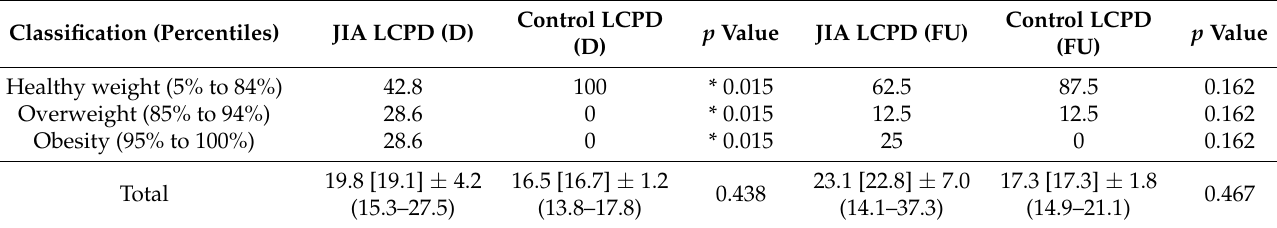
Table 3. Body Mass Index at LCPD diagnosis and at last follow-up.